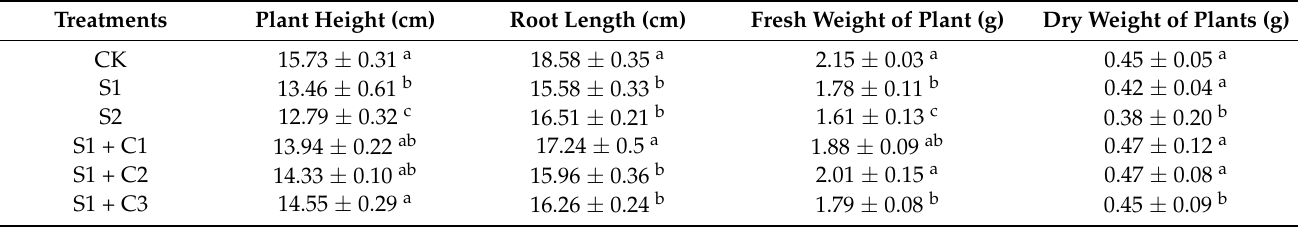
Table 1. Effects of hydroponic cultivation of G. sinensis plants on plant height, root length, fresh weight, and dry weight after one week treatment with different concentrations of NaCl and treatment with different concentrations of exogenous calcium and NaCl.